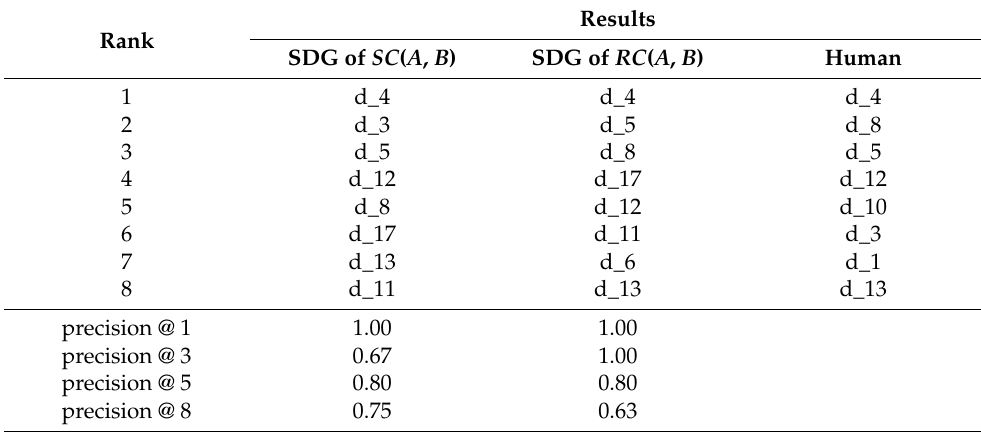
Table 5. Ranking results of Models SC ( A , B ) and RC ( A , B ) as well as human evaluation for median cognitive diversity case: CD ( A , B ) =